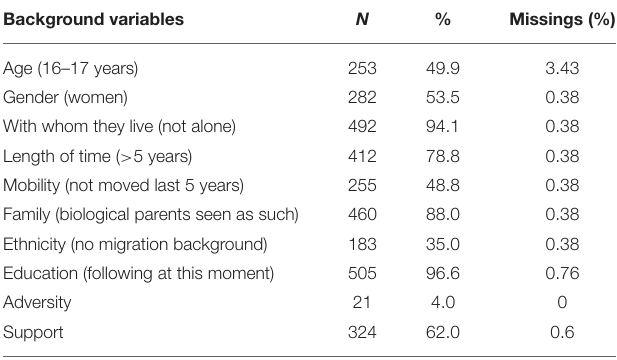
TABLE 1 | Descriptives of the sample ( N =